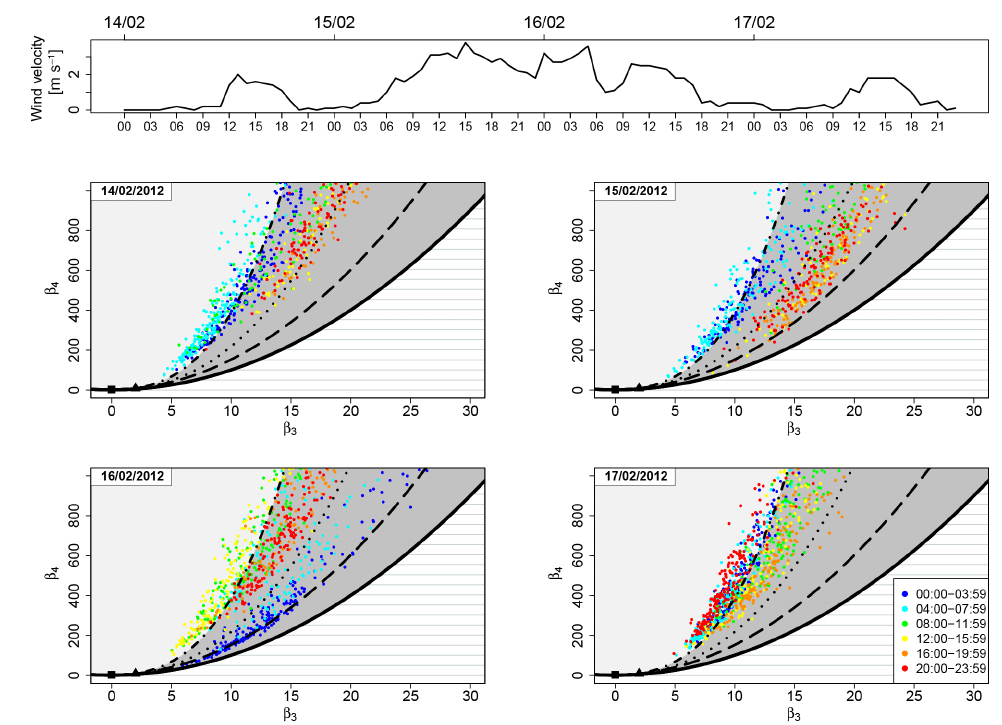
Figure 8. Location of the sample couples ( β 3 , β 4 ) in the skewness–kurtosis plane for the days 14, 15, 16 and 17 February 2012. The dots are coloured according to the time slot as explained in the legend. Between 15 and 16 February, relatively high wind speed with maximum of 3.8ms − 1 (recorded on 15 February at 15:00UTC)